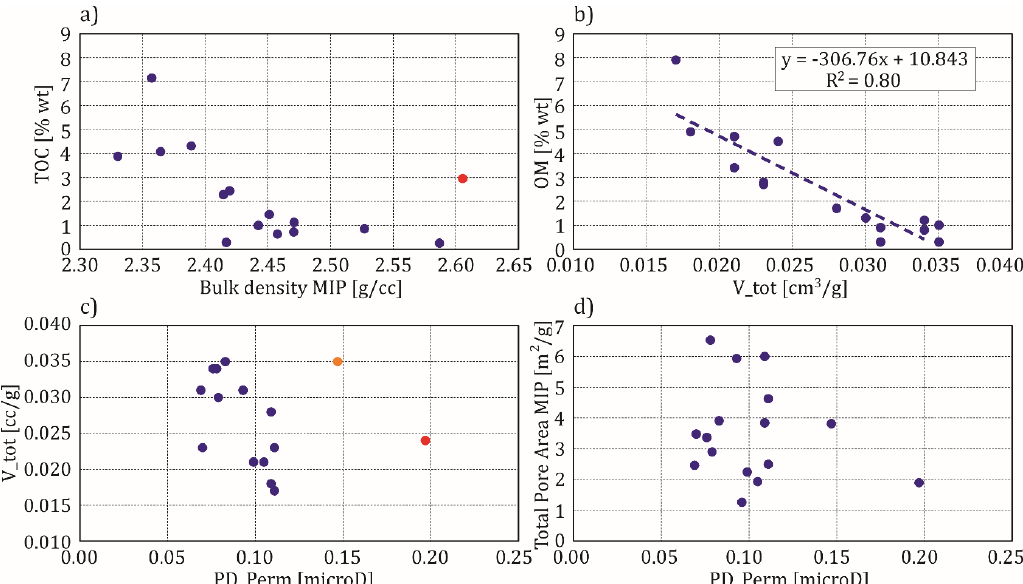
Figure 6. Relationships between parameters determined from standard laboratory experiments on samples from Well-1 and Well-2; ( a ) TOC (Rock-Eval) vs. bulk density from MIP; ( b ) organic matter OM (XRD/TOC analyses) vs. total pore volume V_tot (nitrogen adsorption/desorption at 77 K); ( c ) total pore volume (nitrogen adsorption/desorption N at 77 K) vs. pressure decay permeability PD_Perm; ( d ) total pore area (MIP) vs. pressure decay permeability PD_Perm; red and orange dots represent outliers described in the text.